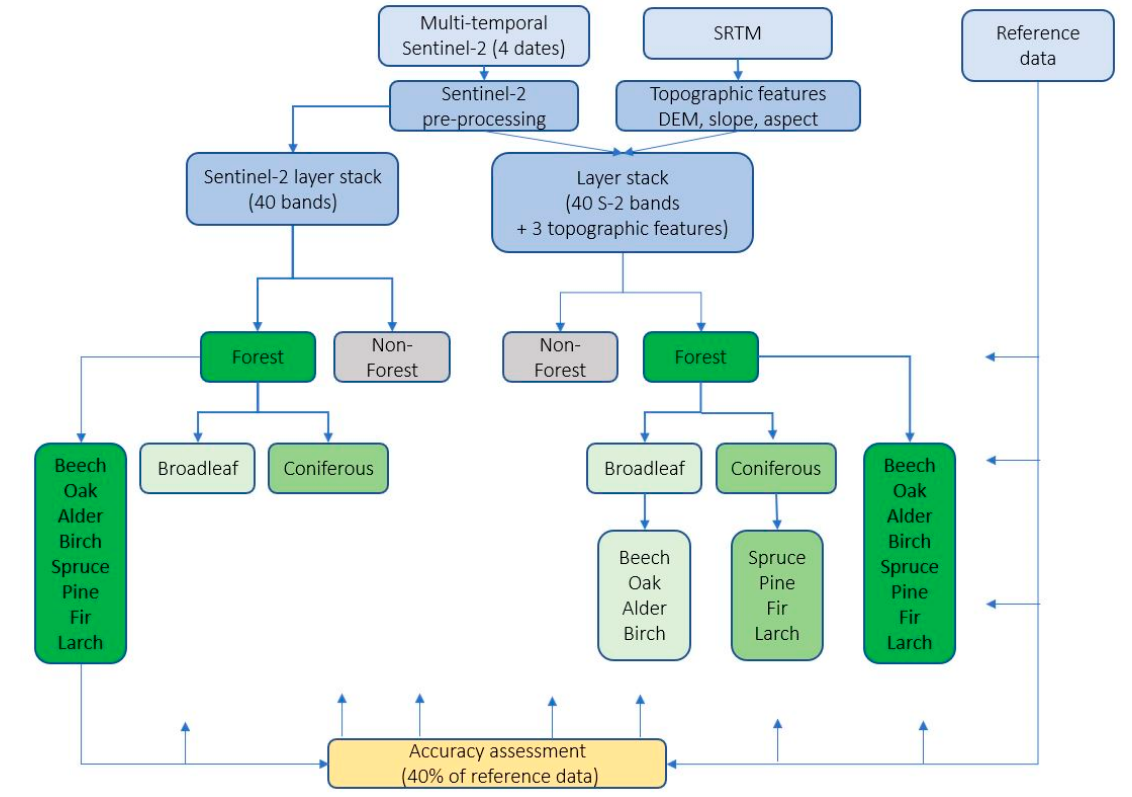
Figure 6. Flowchart of the applied methods for forest/non-forest cover, forest type and species mapping.